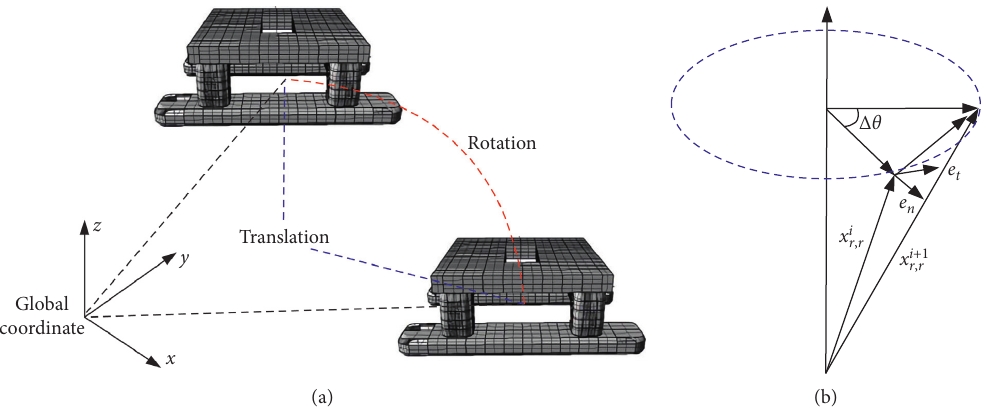
Figure 3: (a) The 6-DOF motion of the platform. (b) The rotation motion of the center of mass.